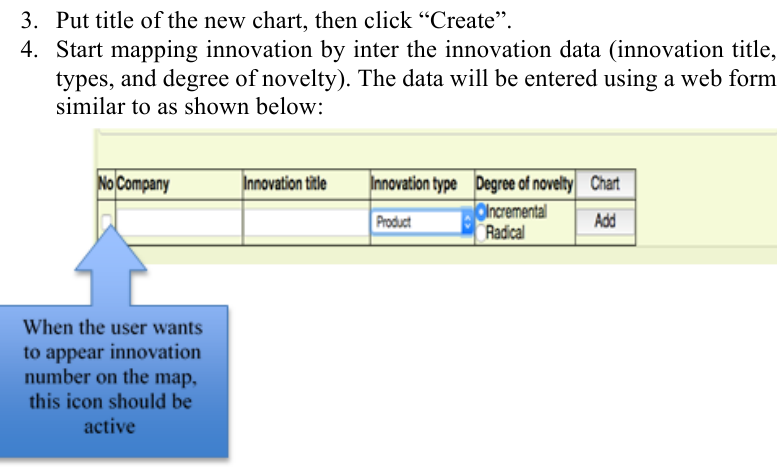
Fig. 7. The 10 Ps Innovation Benchmarking Mapping Model: Registration and Login